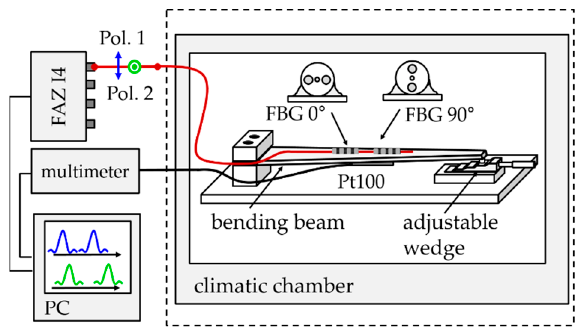
Figure 6. Measurement setup for temperature strain decoupling with surface-glued PM tandem sensor elements. PC, personal computer.